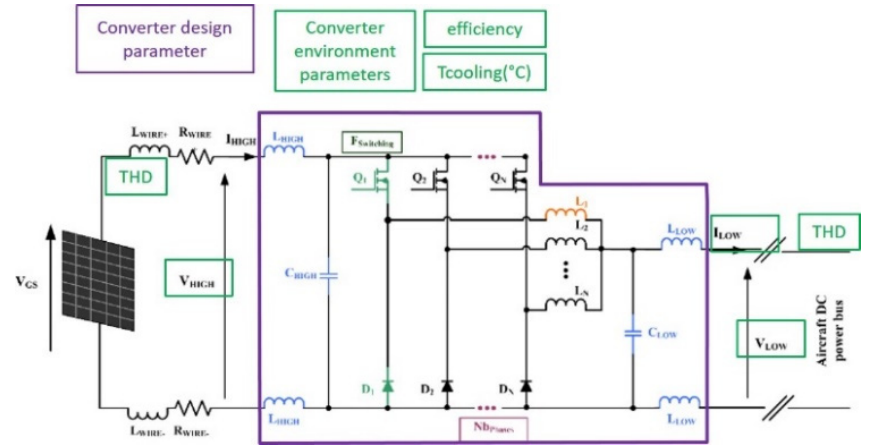
Figure 5. Interleaved Buck Converter schematic.